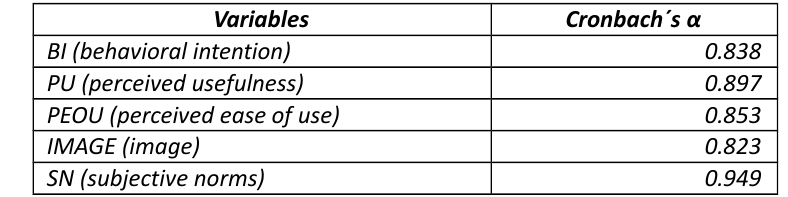
Table 3. Reliability of the scales, according to Cronbach’s alpha